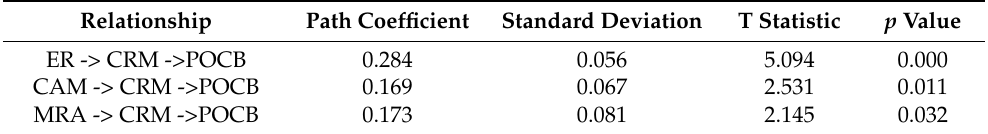
Table 8. Path coefficient and mediating